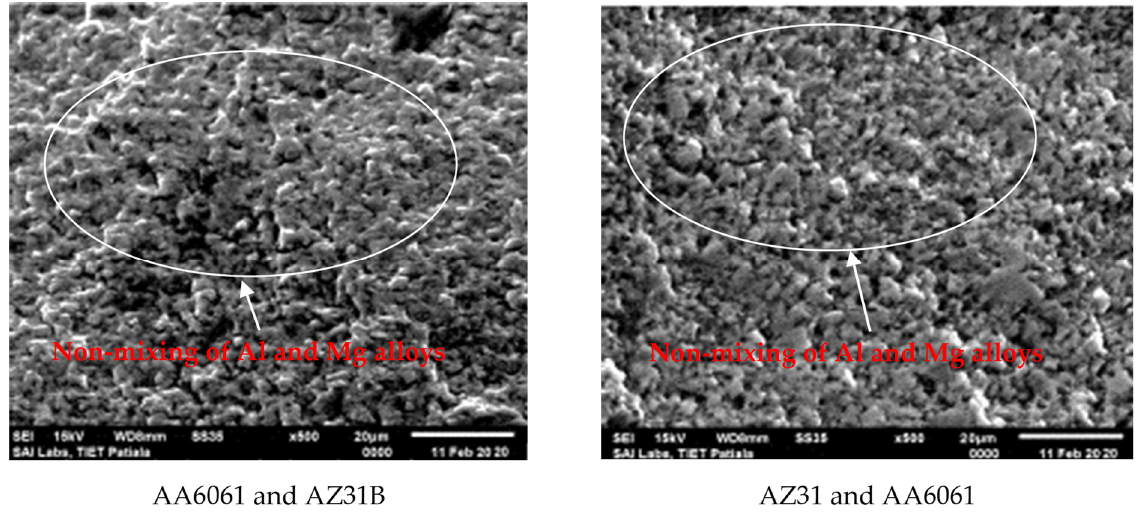
Figure 11. Fractography represents brittle fracture (dual character).